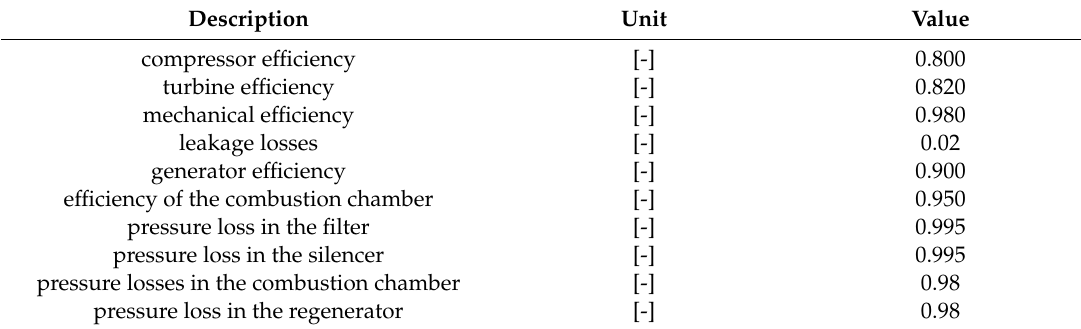
Table 3. Assumptions adopted for the design analysis of turbine generator variants [27,51].